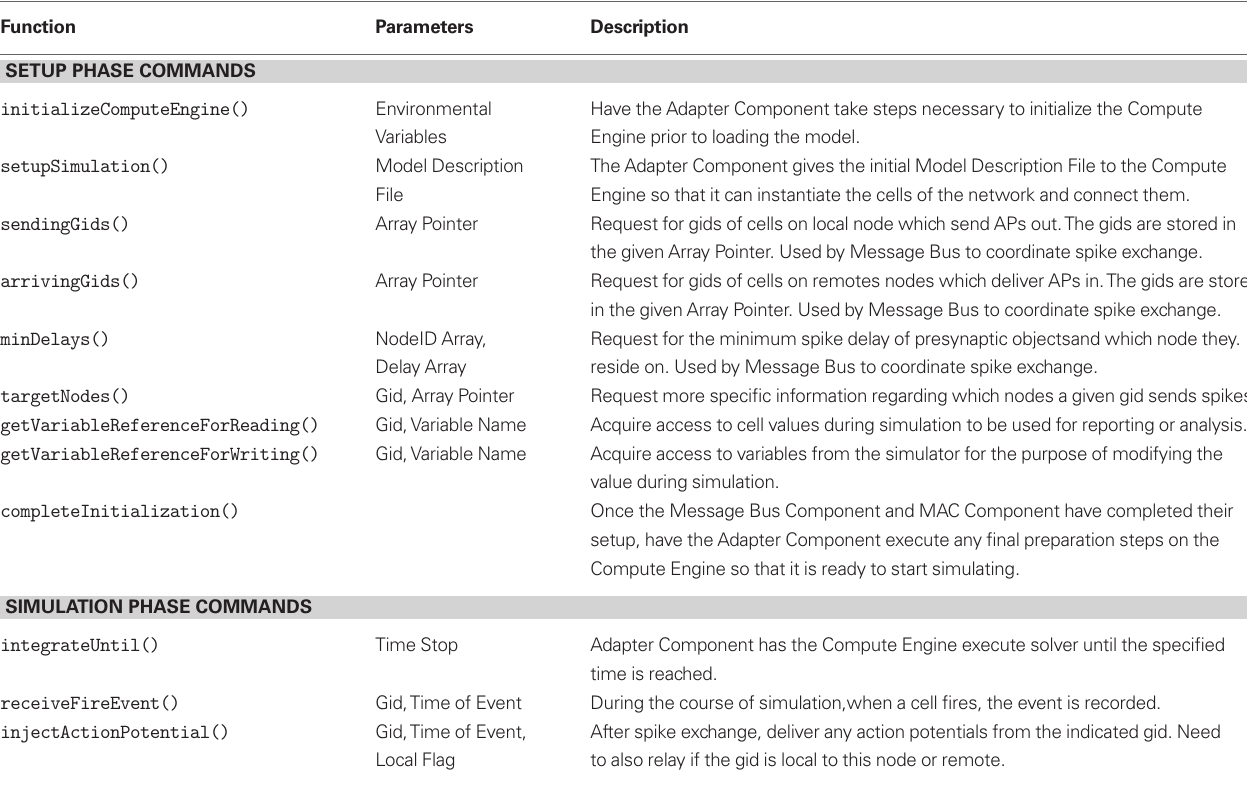
Table 1 | Interface functions of the Adapter Component during setup and simulation